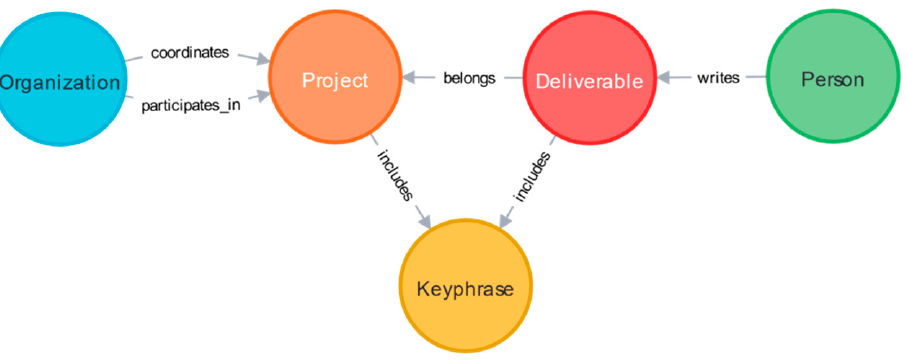
Figure 3. Schema of the knowledge graph.